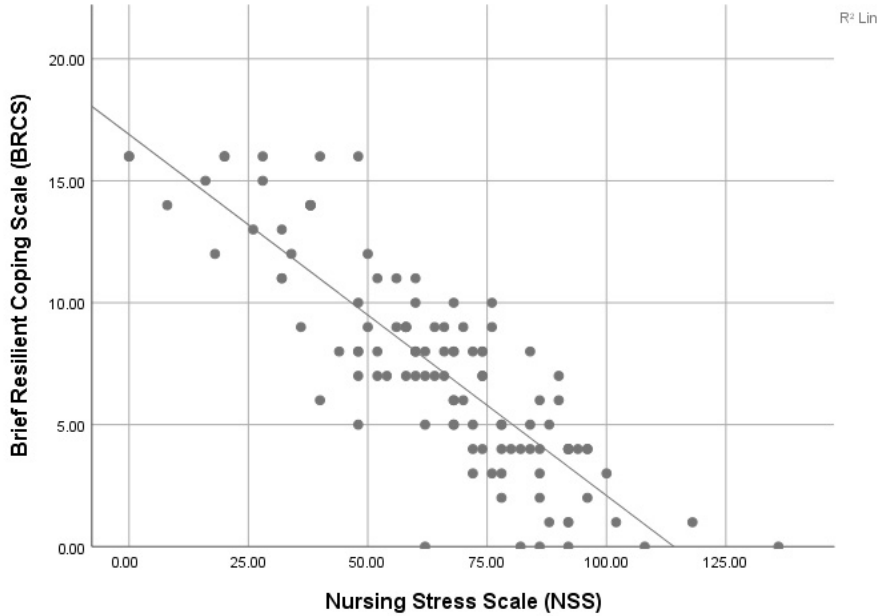
Figure 2. Scatterplot between Nursing Stress Scale and Brief Resilient Coping Scale among Studied Subjects. Table 3. Nursing Stress Scale Subscales Score and Correlation with Total Score and Brief Resilient Coping Table 2. Total Score of Nursing Stress Scale and Brief Resilience Coping Scale among Studied Nurses. ( n = 113).